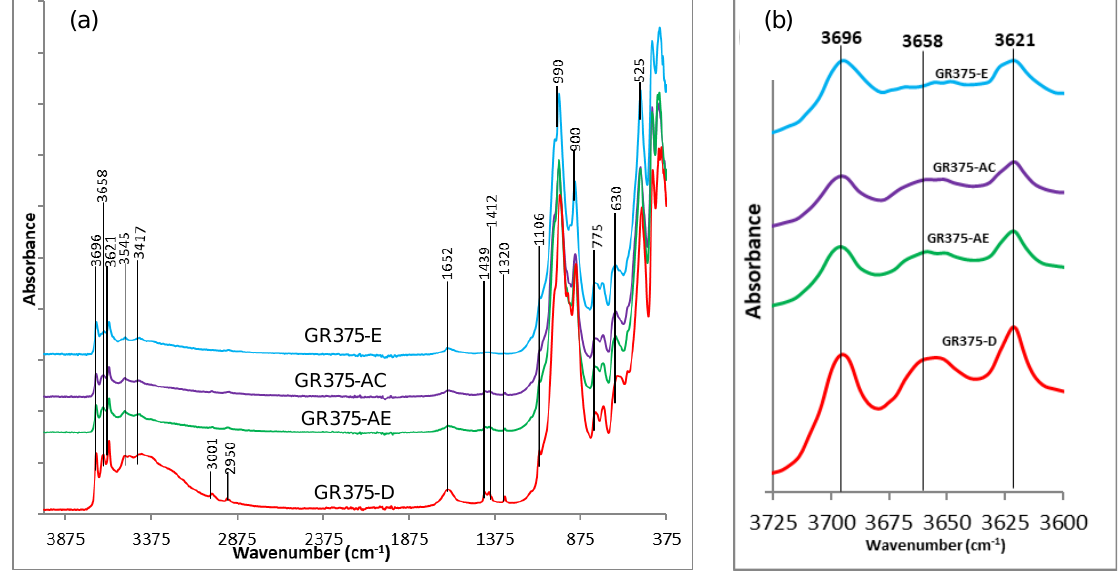
Figure 5. FTIR ( a ) complete spectra and ( b ) zooming of the OH stretching domain of DMSO–Kaolinite (GR875-D) and the products of deintercalation in water (GR375-E), in ethyl acetate (GR375-AE) and in acetone (GR375-AC).